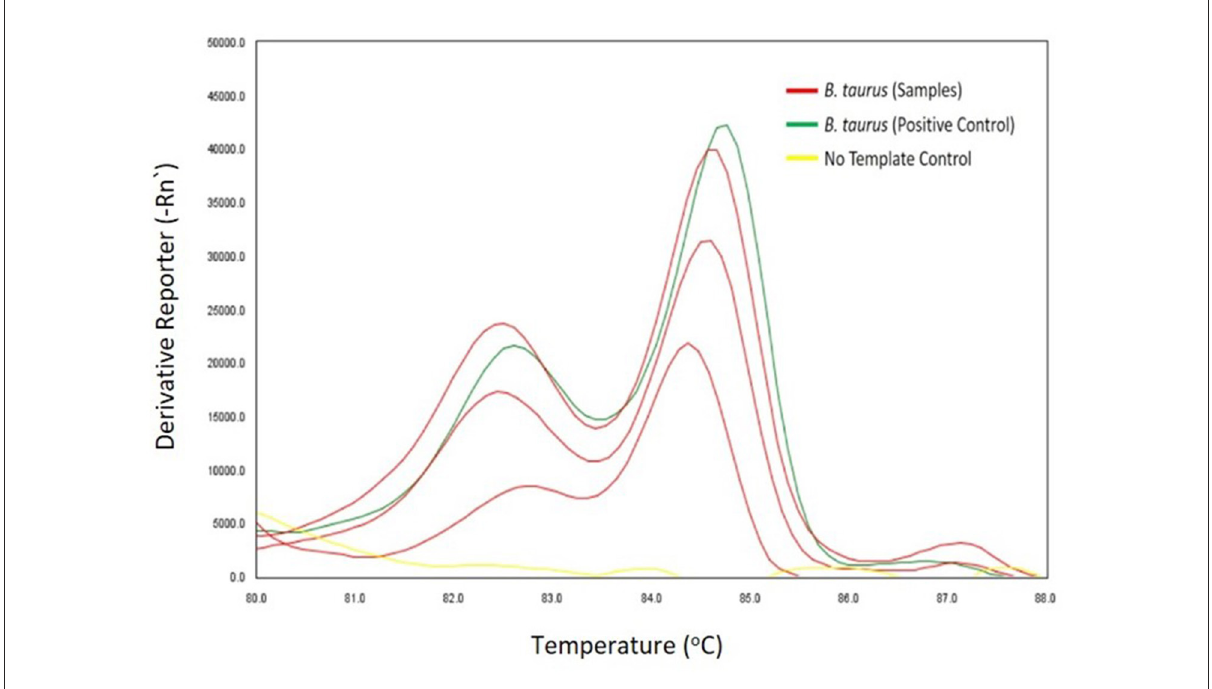
FIGURE3 HRM profiles showing melting curves of cattle DNA.